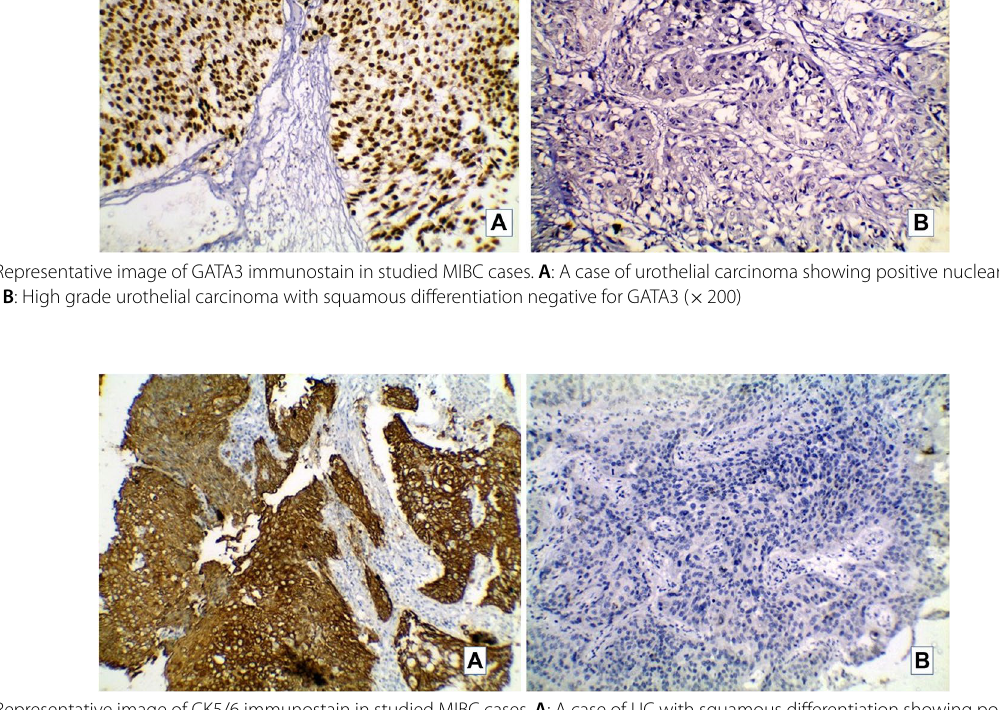
Fig. 2 Representative image of CK5/6 immunostain in studied MIBC cases. A : A case of UC with squamous differentiation showing positive cytoplasmic CK5/6 (